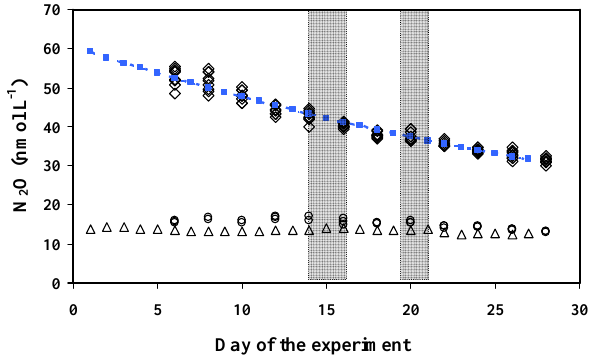
Fig. 2. N 2 O concentrations during the experiment. Diamonds ( (cid:5) ) represent the measured concentration inside the three examined Fig. 2 798 mesocosms; blue squares ( (cid:3) ) are fitted daily concentrations ac- N 2 O concentrations during the experiment. Diamonds ( ) represent the measured 799 cording to equation 2, circles ( ◦ ) are background N 2 O concentra- tions measured in the surrounding fjord, triangles ( 4 ) are calcu- concentration inside the 3 examined mesocosms; blue squares ( ) are fitted daily 800 lated equilibrium concentrations from atmospheric measurements concentrations according to equation 2, circles ( ) are background N 2 O concentrations 801 at in situ T and S . Shaded areas indicate periods when waves (up to measured in the surrounding fjord, triangles ( ) are calculated equilibrium concentrations 802 H 1 / 3 = 0.8m) occurred at the mooring from atmospheric measurements at in situ T and S. Shaded areas indicate periods when waves 803 (up to H 1/3 = 0.8m) occurred at the mooring site. 804